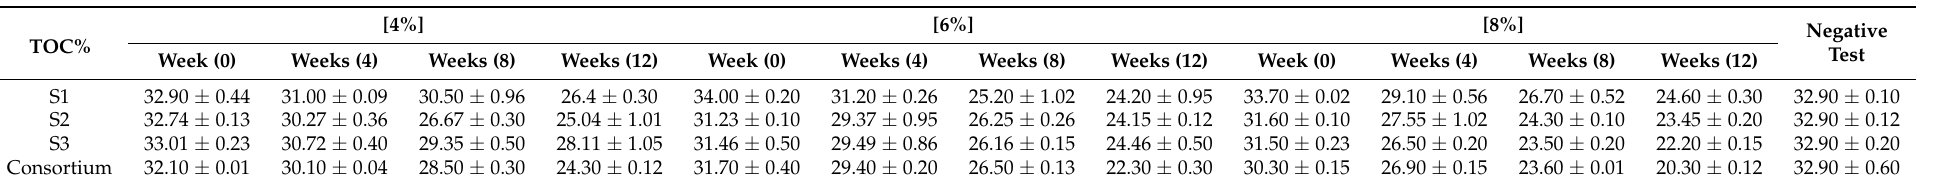
Table 2. Evolution of TOC degradation of the three isolated strains (S1: Strain 1; S2: Strain 2; S3: Strain 3) and their consortium as function of the time at different inoculum doses (4%, 6%, and 8%).